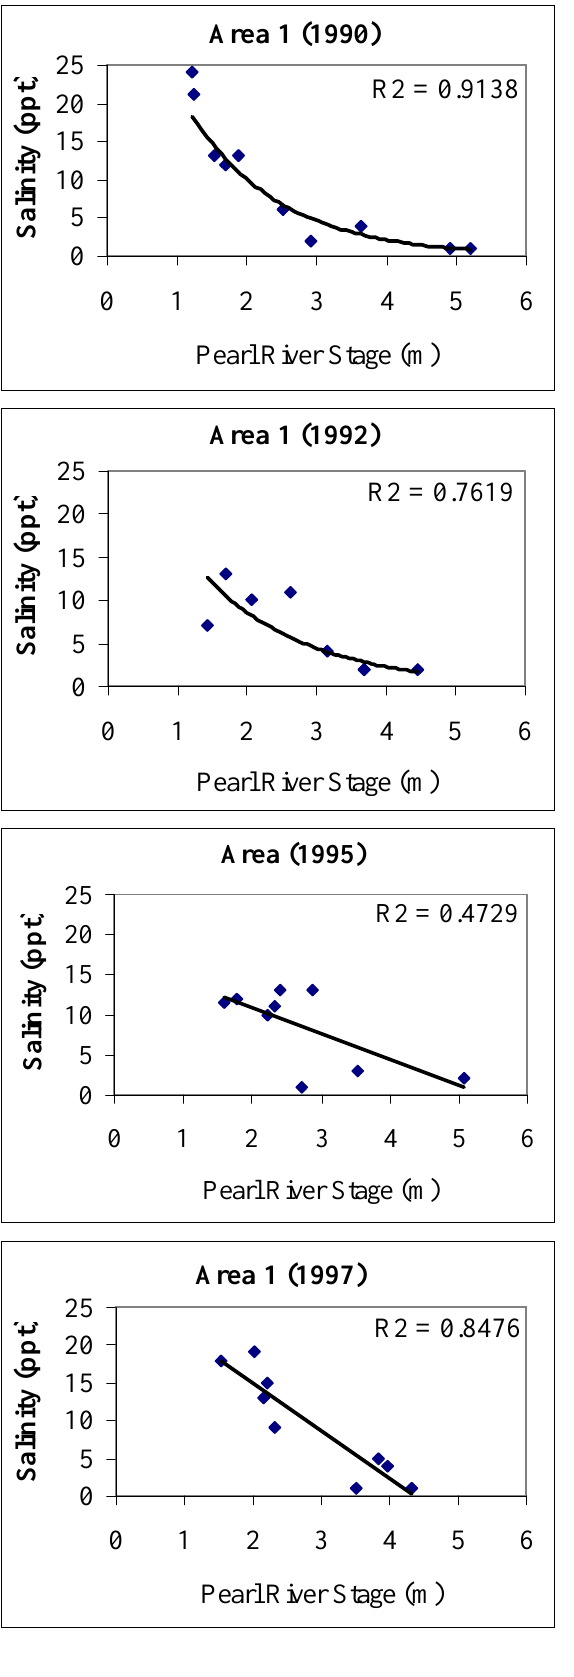
Figure 7: Plot of salinity against Pearl River stage for various years